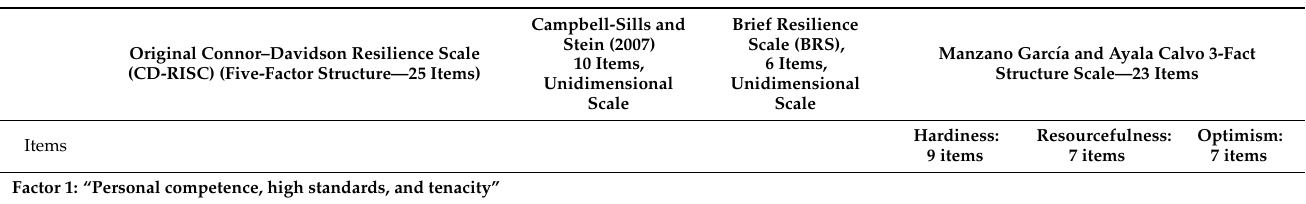
relationships”, “control”, and “spiritual influences”. The items related to each factor are illustrated in Table 1. Table 1. Original Connor–Davidson resilience scale (CD-RISC) and other extracted